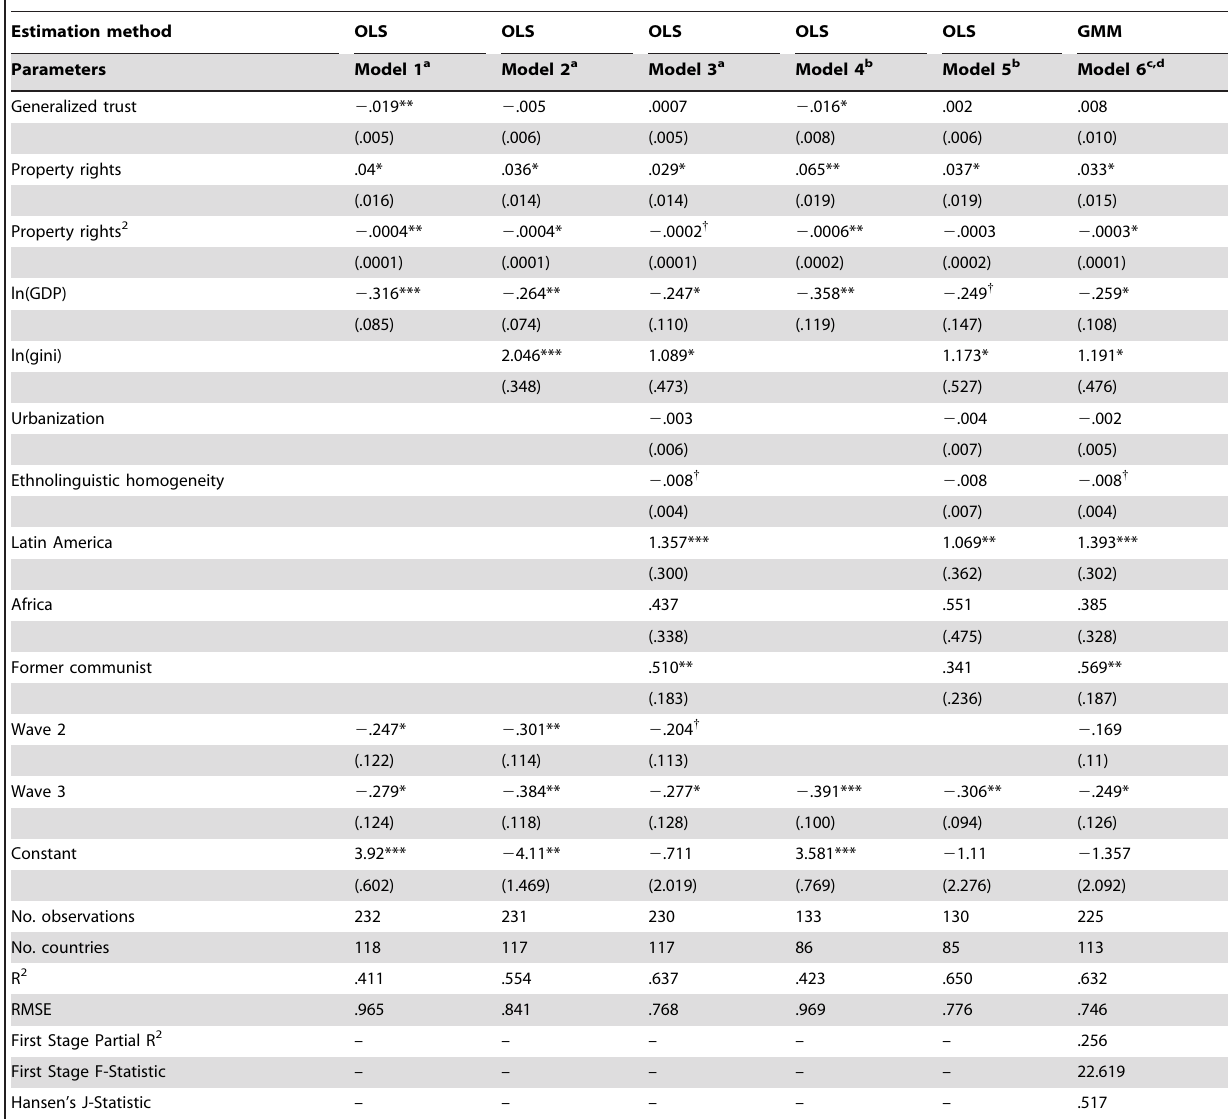
Table 2. Intentional homicide and generalized trust: A pooled time-series